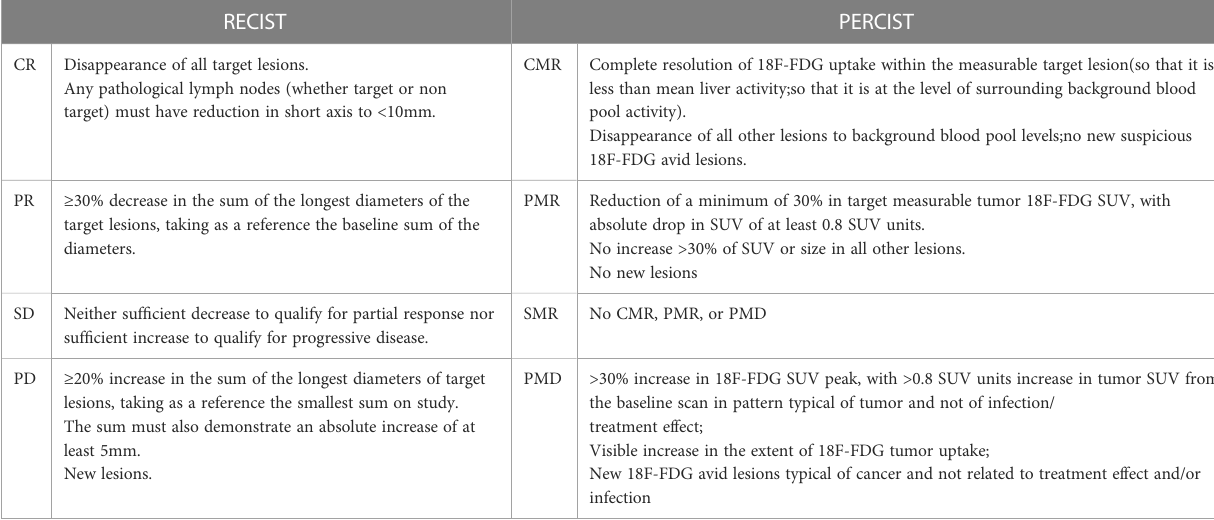
TABLE 1 Comparison of RECIST and